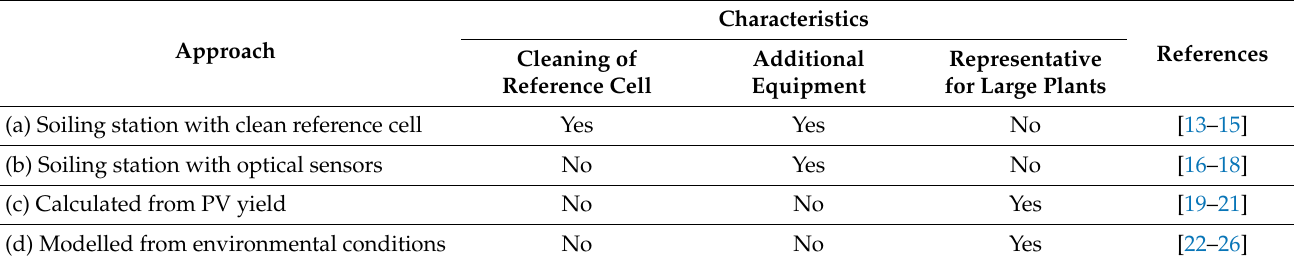
Table 2. Methods for determining actual soiling